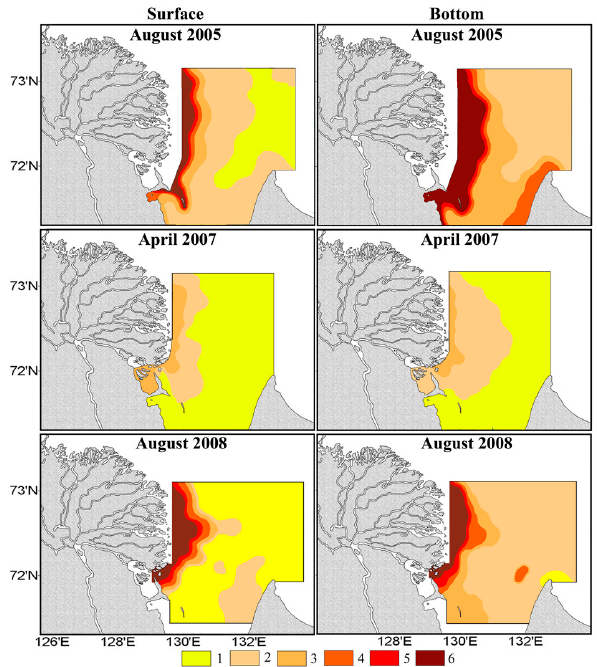
Fig. 5. Distribution of SPM (mgl − 1 ).